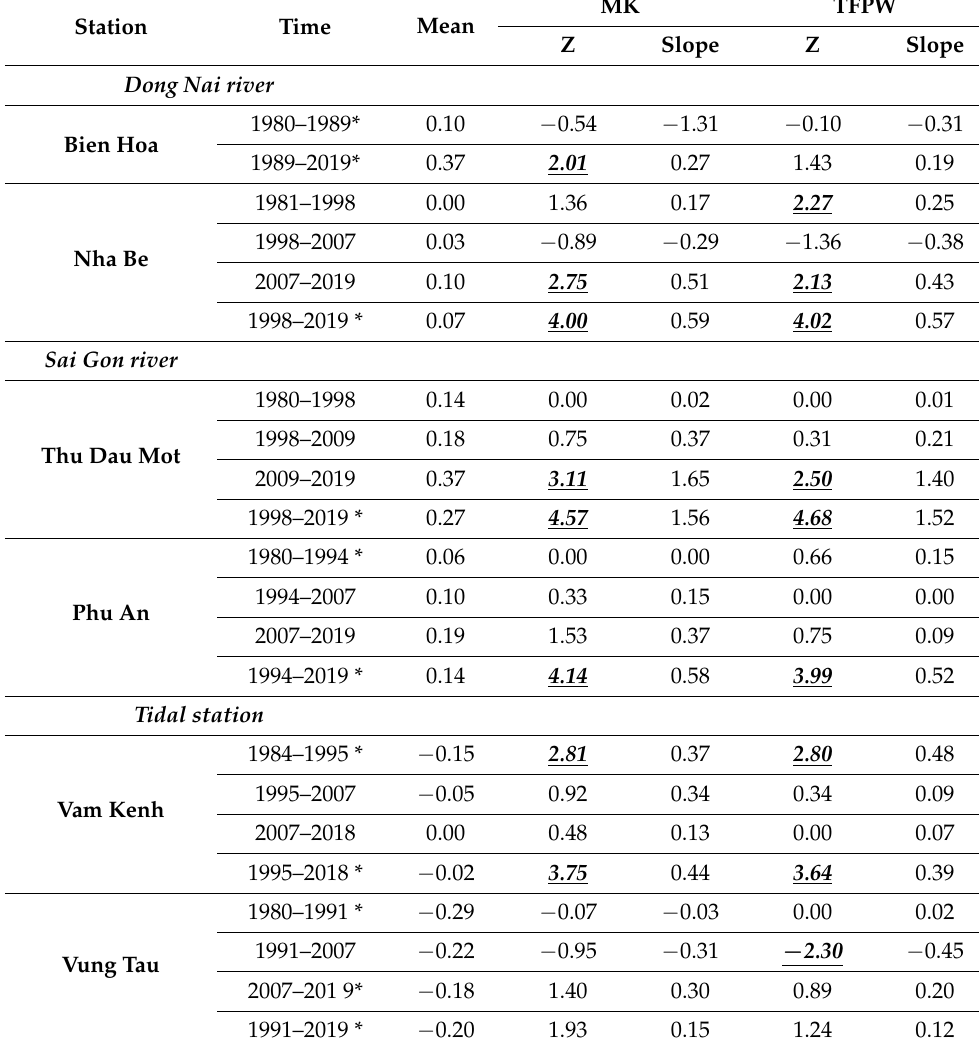
Table 8. Periodic water level trend at H mean